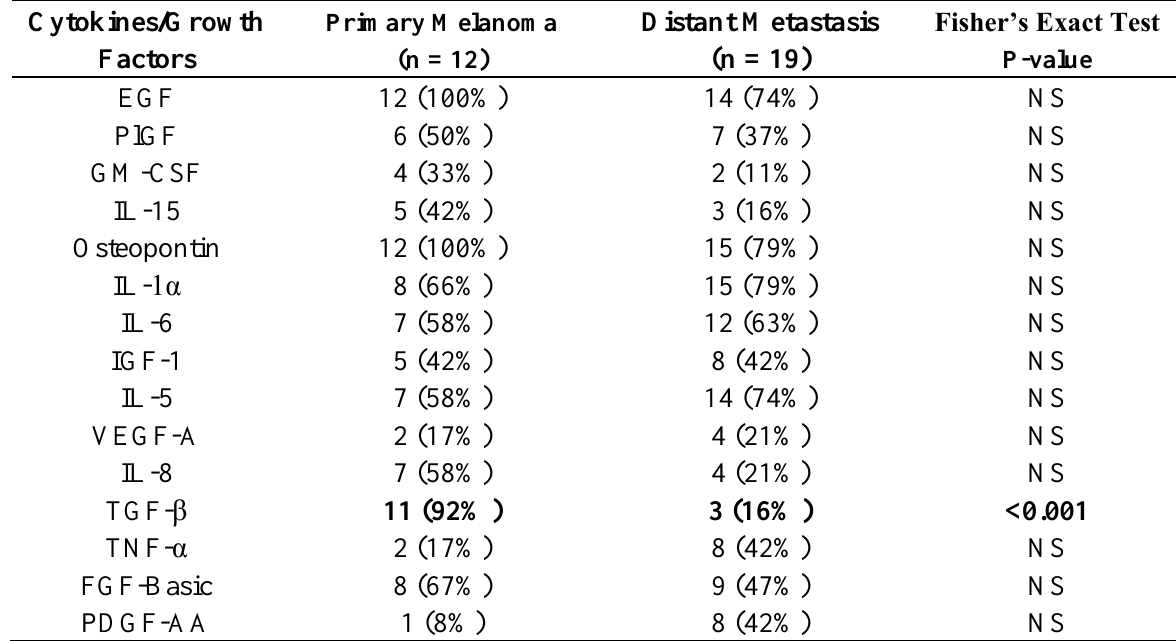
Table 4. Percent of melanoma cases overexpressing the cytokines/growth factors evaluated by the intensity of immunohistochemical staining.